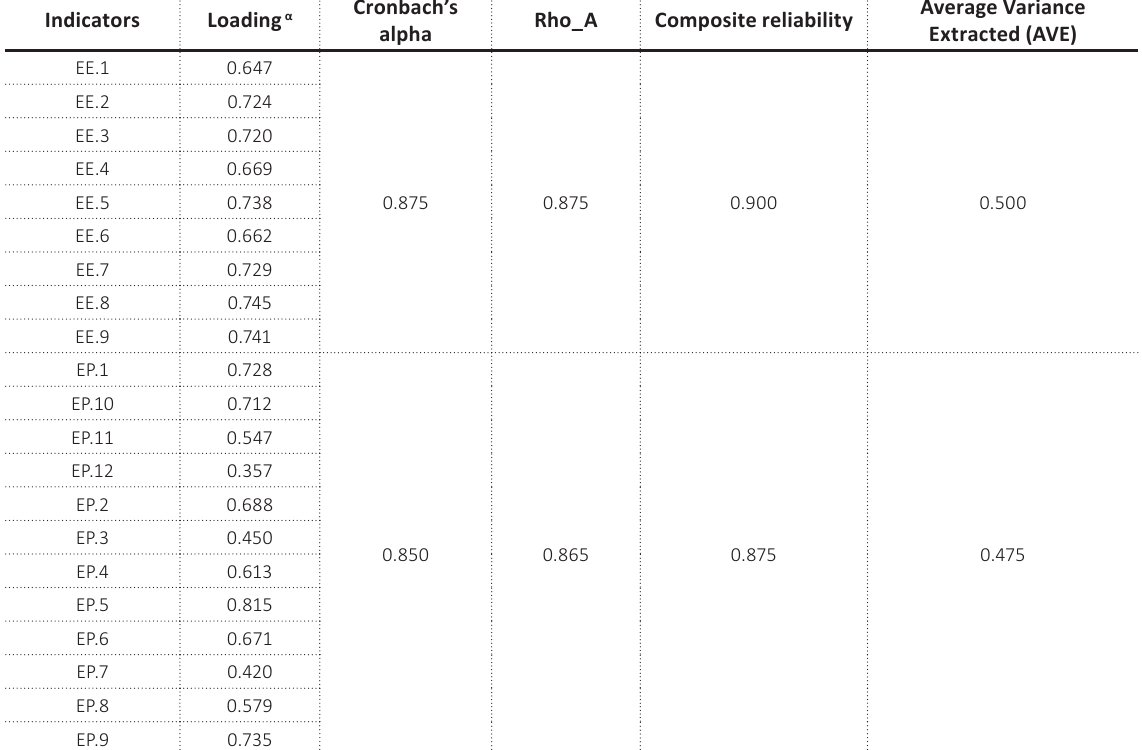
Table 2. Factor loading and